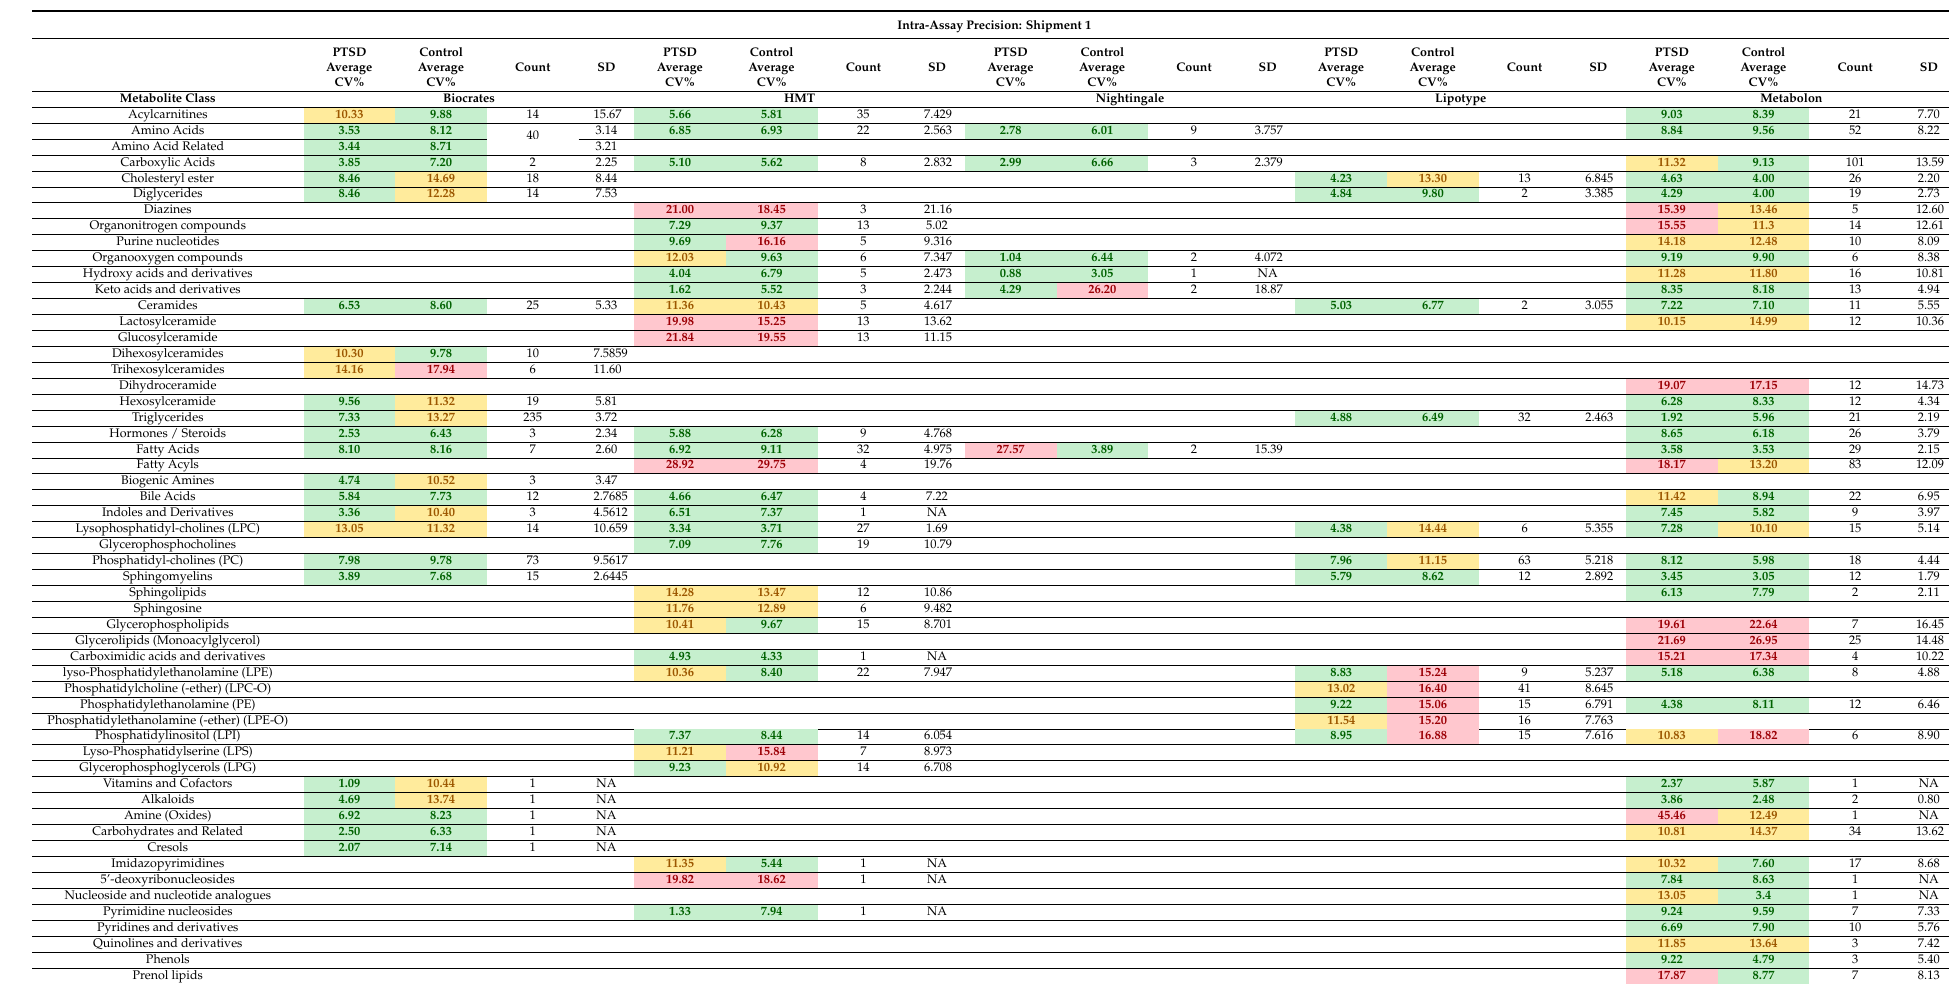
Table 1. Intra-assay Percent Coefficient of Variance (CV%) within Metabolite Classes and CV% Standard Deviation (SD) for Technical Replicates of PTSD and Control Samples in Shipment